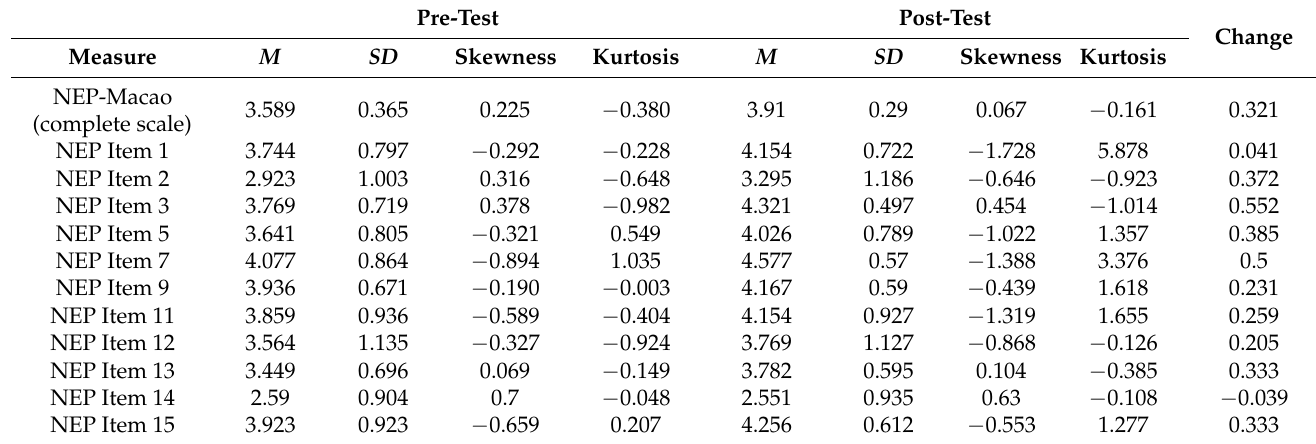
Table 4. Summary of descriptive statistics for NEP-Macao items ( n =